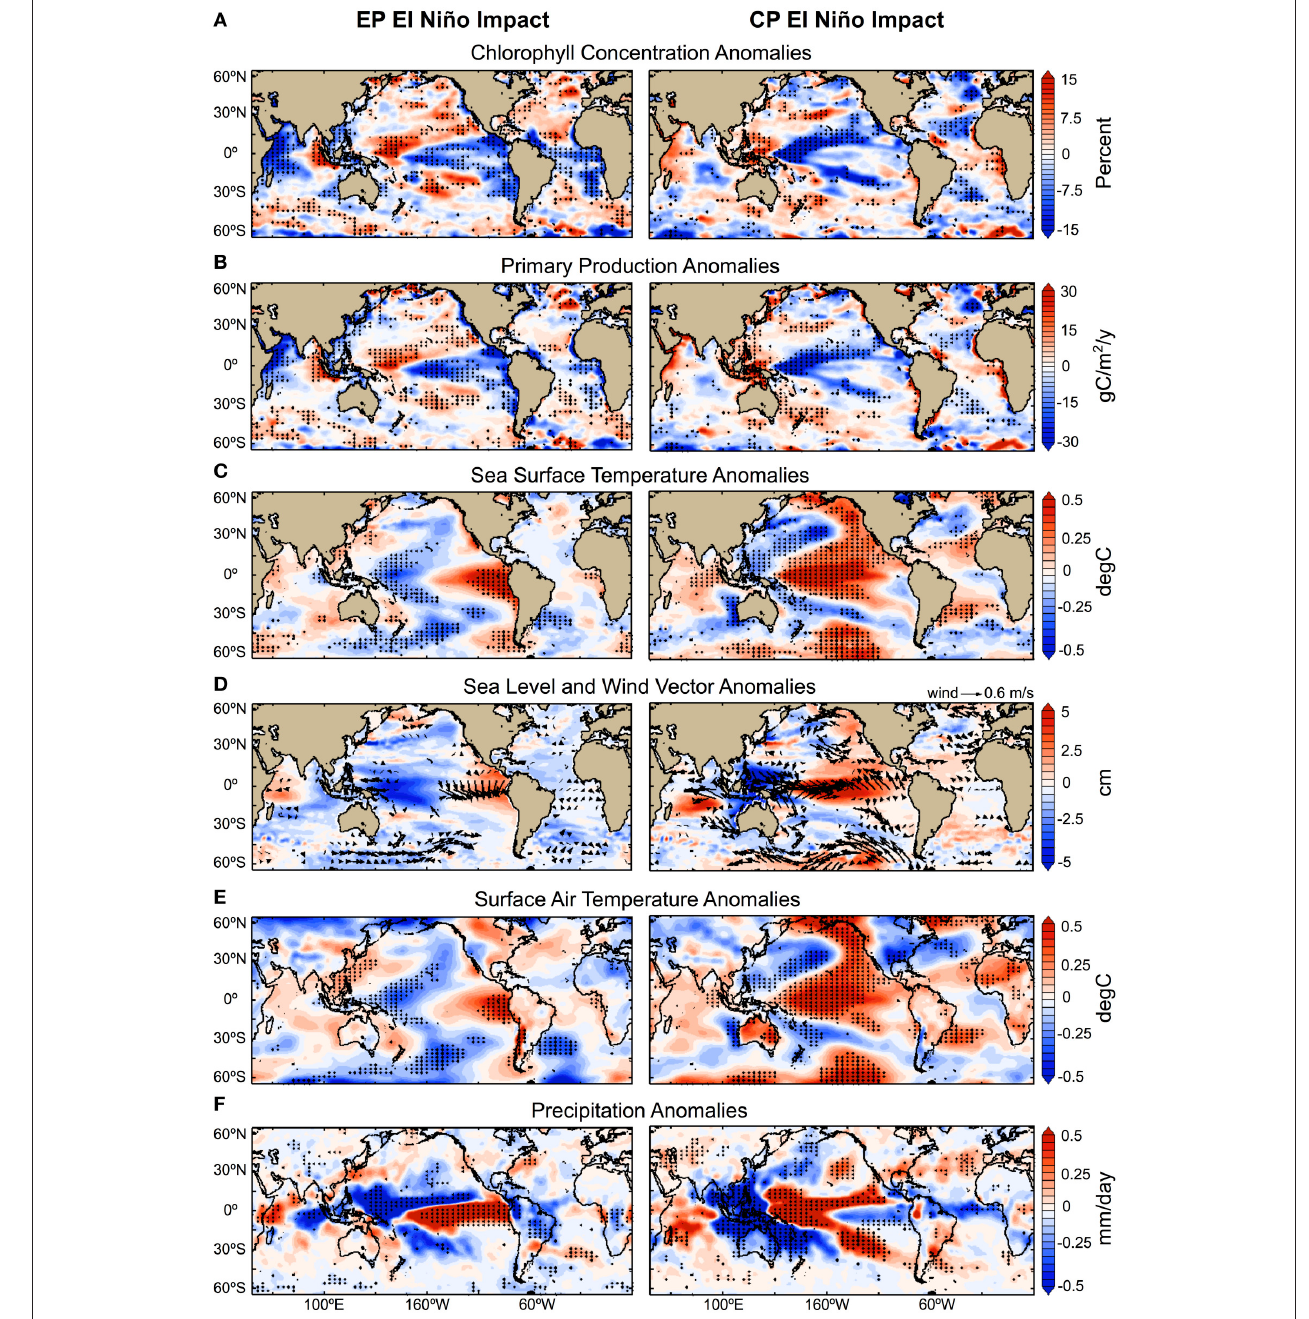
FIGURE 2 | Observed impacts of Eastern and Central Pacific El Niño on biological and physical variables during 1997–2012. Annual mean anomalies are regressed onto the (left) EP and (right) CP El Niño indices. Increase and decrease are indicated by positive (red) and negative (blue) anomalies respectively. (A) Chlorophyll Concentration anomalies; (B) Primary Production anomalies; (C) SST anomalies; (D) SL and wind anomalies; (E) Surface Air Temperature anomalies; and (F) Precipitation anomalies. In all panels, stippling indicates where the linear regression coefficients are significant at the 90% confidence level over the entire period of 1997–2012. The statistical significance of these regression coefficients was estimated according to Student t -test and considering the autocorrelation of the time-series. The impact values are estimated based on EP and CP indices equal to